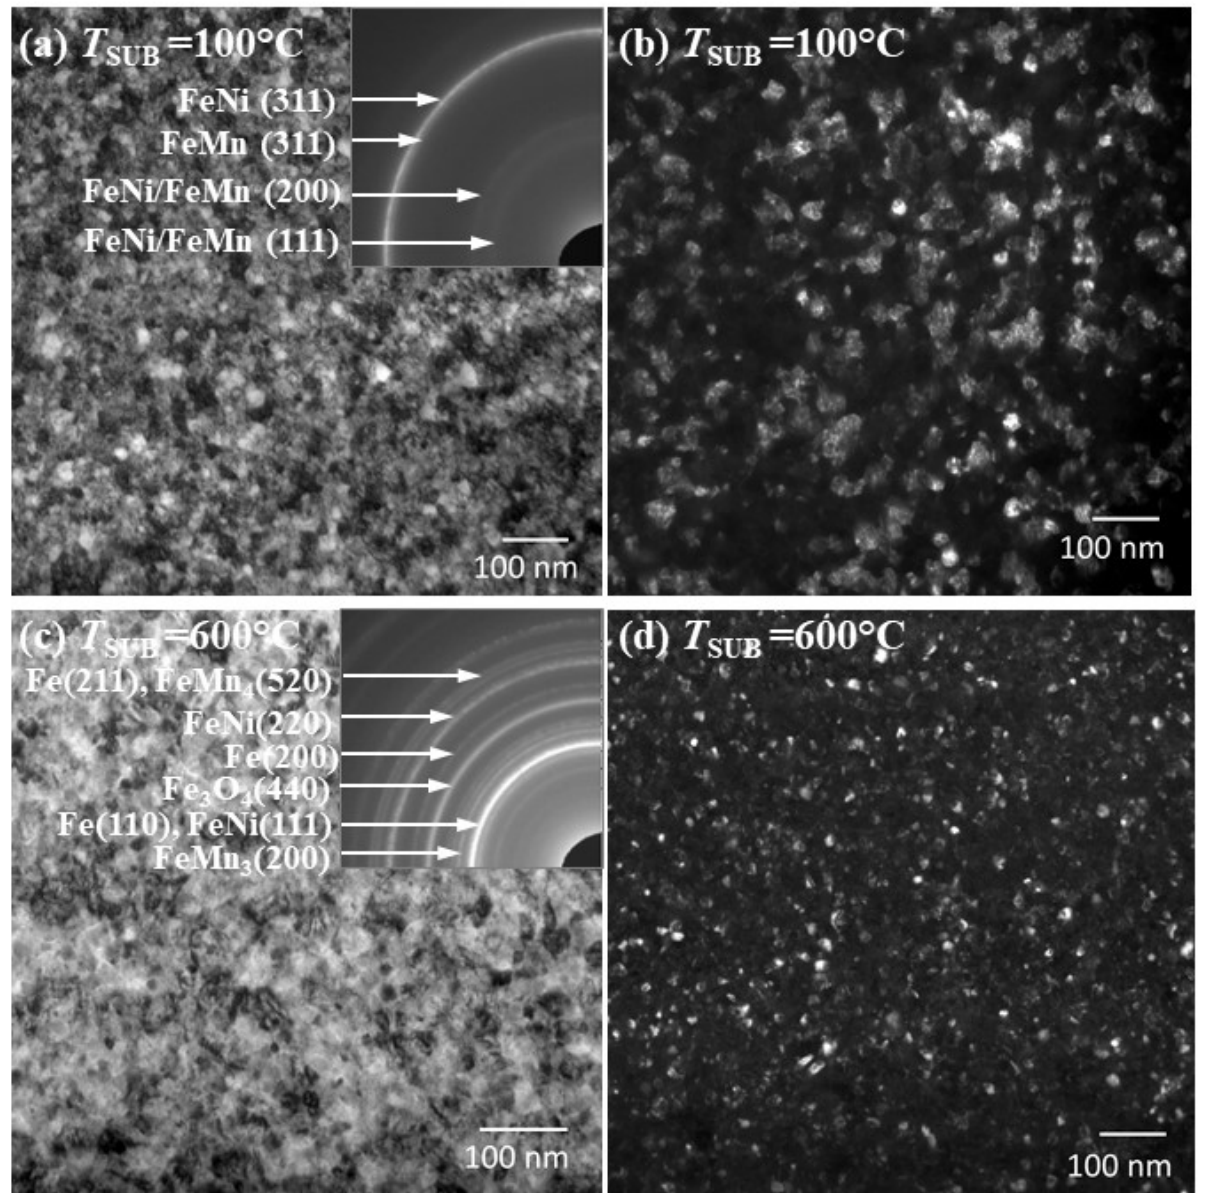
Figure 2. Planar TEM images and SAED patterns (insets in ( a , c )) for thin films NiFe (40 nm)/FeMn (20 nm) deposited at: ( a , b ) 100 ◦ C; ( c , d ) 600 ◦ C of the substrate temperature. XRD analysis was used to find out whether FeNi and FeMn layer grain size